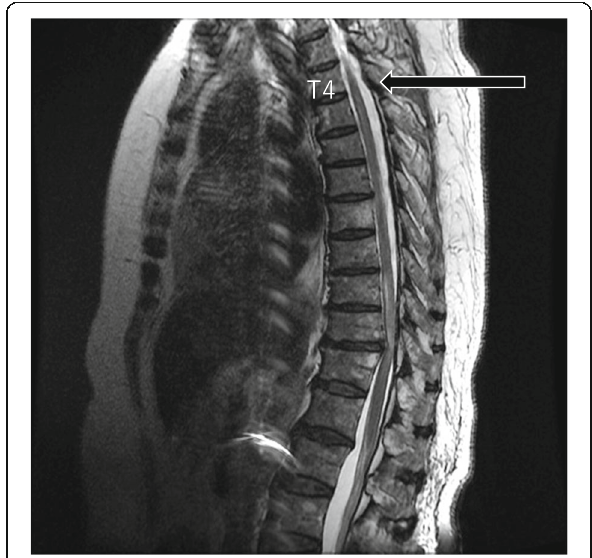
Fig. 3 One week after the operation, sagittal MRI revealed that the hyperintense region had extended to approximately the T4 level